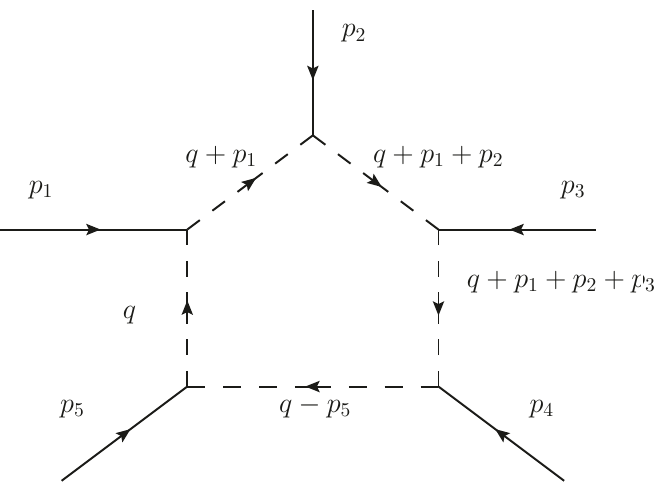
Figure 17. This diagram de(cid:12)nes H ( p 1 ; p 2 ; p 3 ; p 4 ; p 5 ) in (B.29). Note that by momentum conser- vation p 1 + p 2 + p 3 =